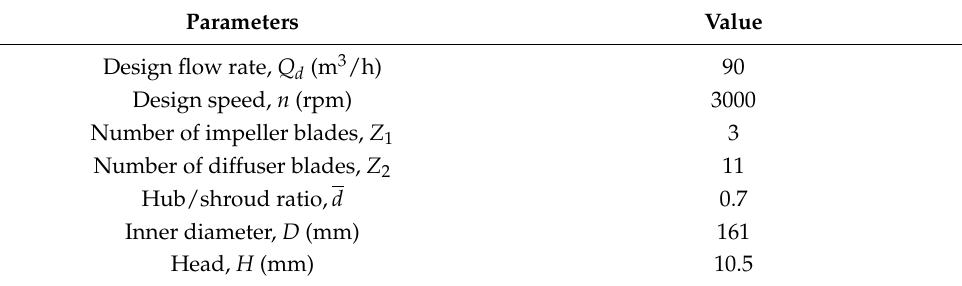
Figure 4. High-speed photography.